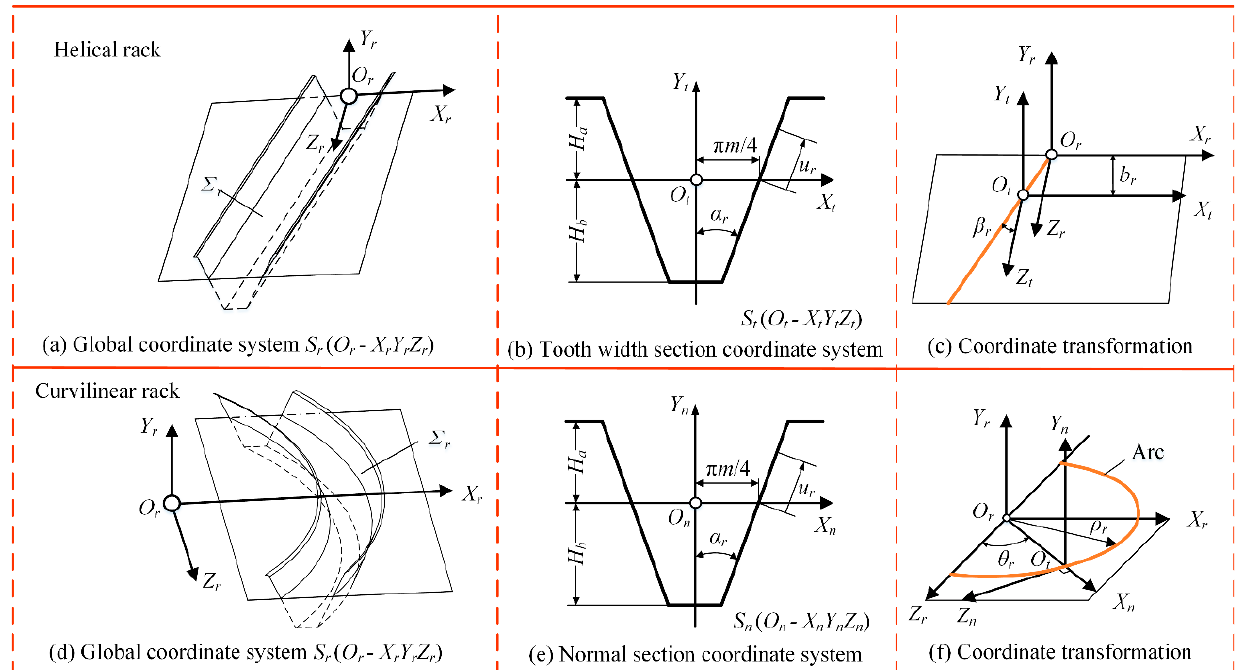
is a helical tooth or curvilinear tooth. When the helix angle β r is 0, it is a straight tooth generating rack.